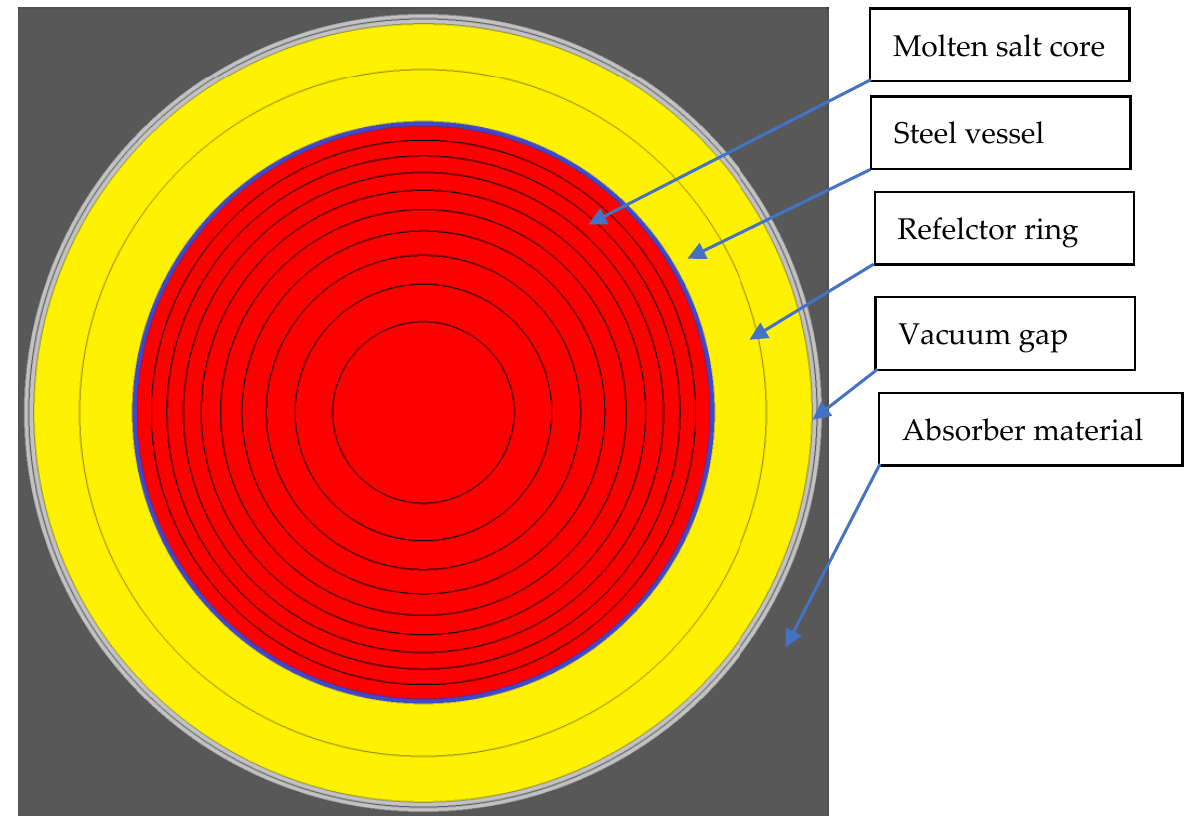
Figure 2. 2D POLARIS ring model of the full-size molten salt reactor core (red) surrounded by a steel vessel (blue), and a reflector ring (yellow), a vacuum gap (light grey), surrounded by absorber (dark grey) .